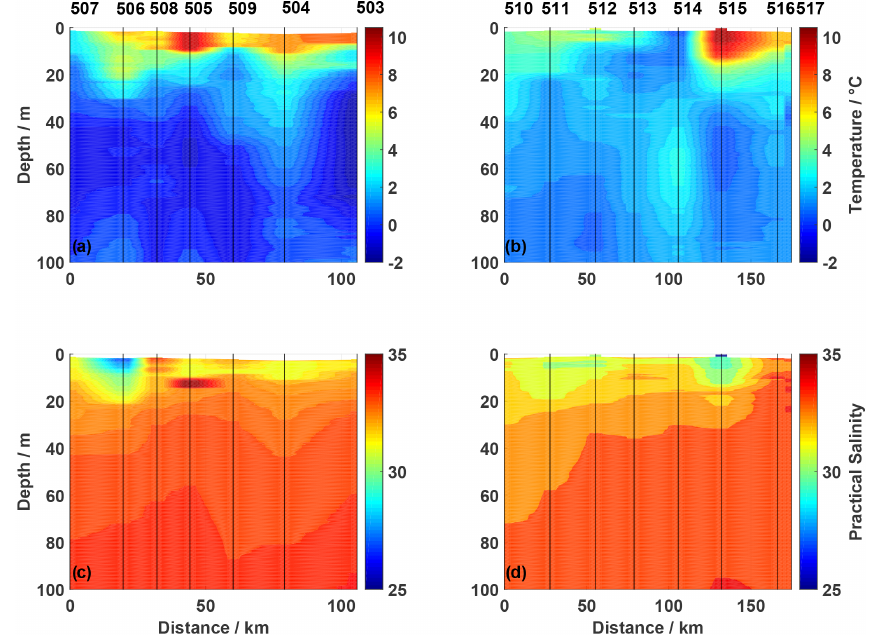
Figure 2. Hydrographic conditions in the Uummannaq Fjord (left, a and c ) and in Vaigat–Disko Bay (right, b and d ). Temperature is shown the top and salinity at the bottom.